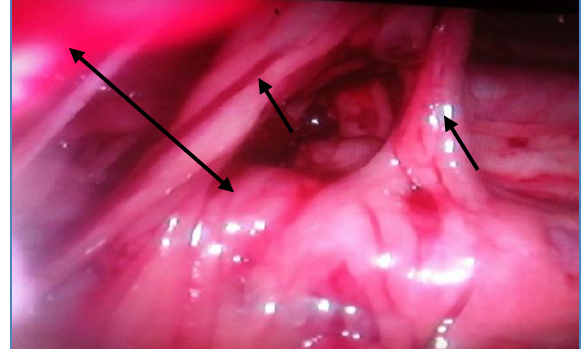
Figure, 2: Laparoscopic image of pelvic cavity shows sever vascularized adhesions (arrows) coveringthe viscera and bind it with abdominal wall ( ), (grade, 4), at 3oth daypost-operation in group A.